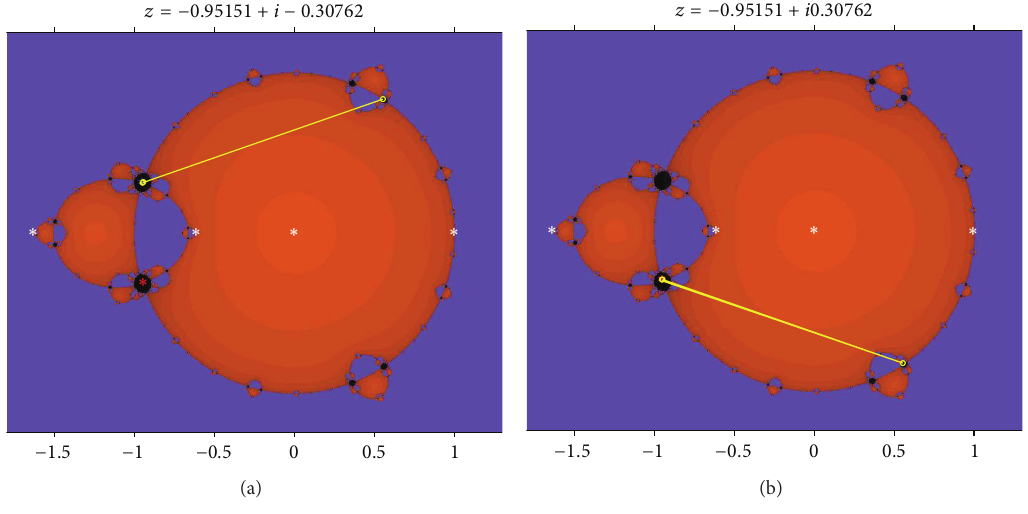
Figure 2: Two 2-cycles in the dynamical plane for 𝛼 = 0.376 .